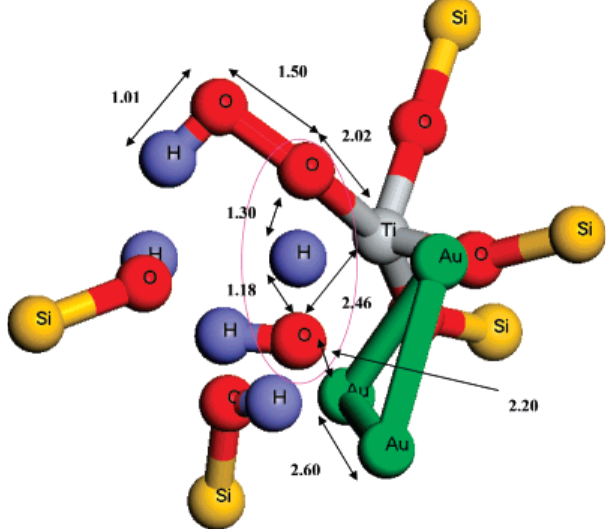
Figure 3. The transition state geometry for attack of H Ti-OOH species inside the TS-1 pores. All of the MM atoms and some atoms in the QM region were removed for clarity. The atomic distances in Å are indicated. Reproduced with permission from Reference [20]. Copyright (2007) American Chemical